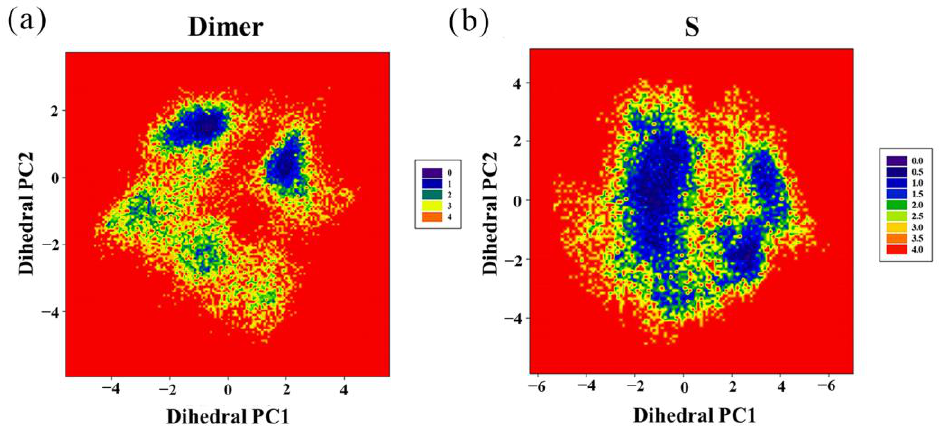
Figure 7. Free energy landscapes (KT) of the ( a ) dimer system and ( b ) S system. PC1 and PC2 represent principal components 1 and 2, respectively.